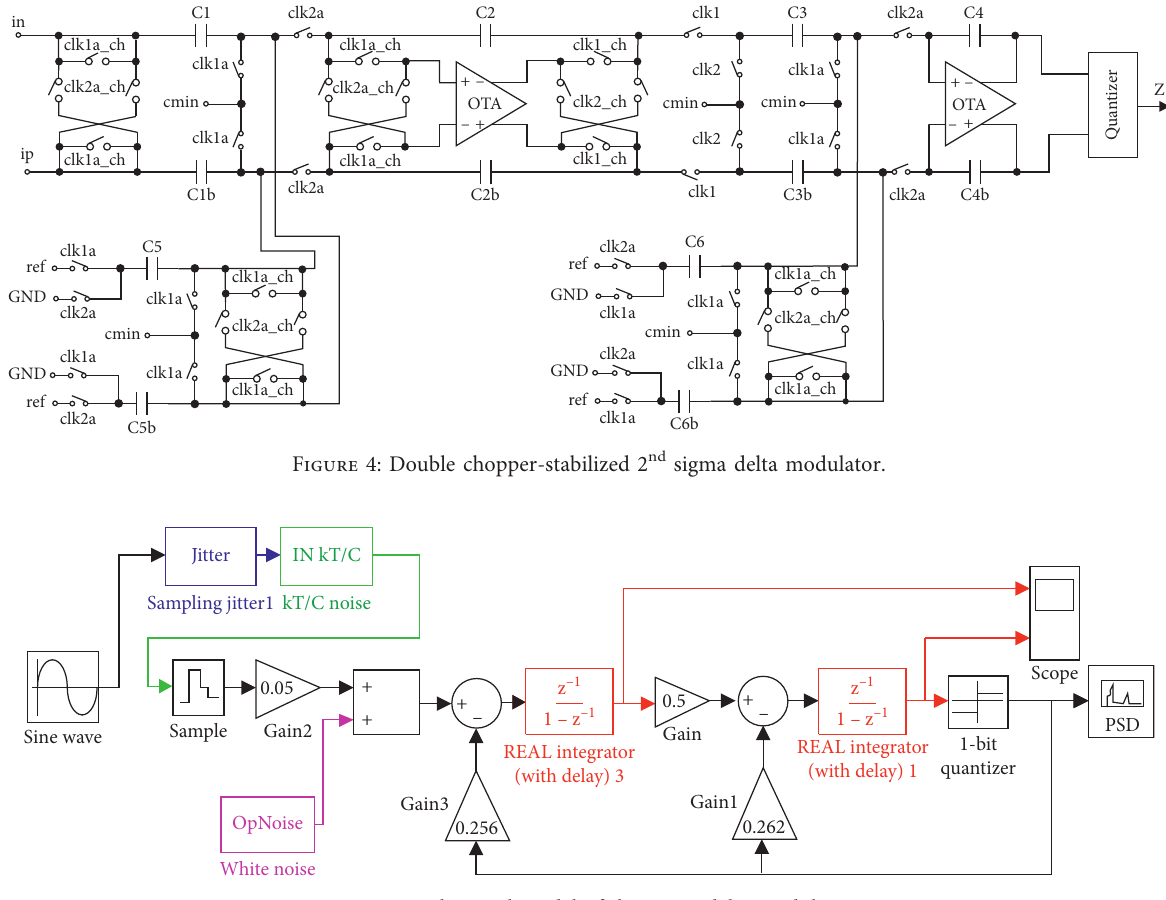
Figure 5: Behavioral model of the sigma delta modulator.